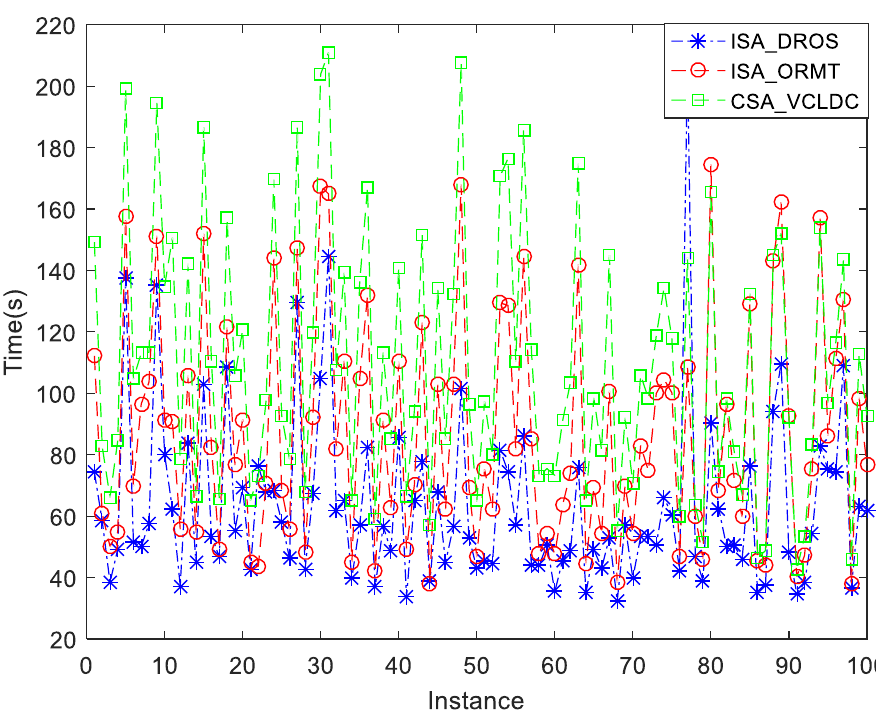
Figure 15. The average running time of the three algorithms running 30 times, respectively.